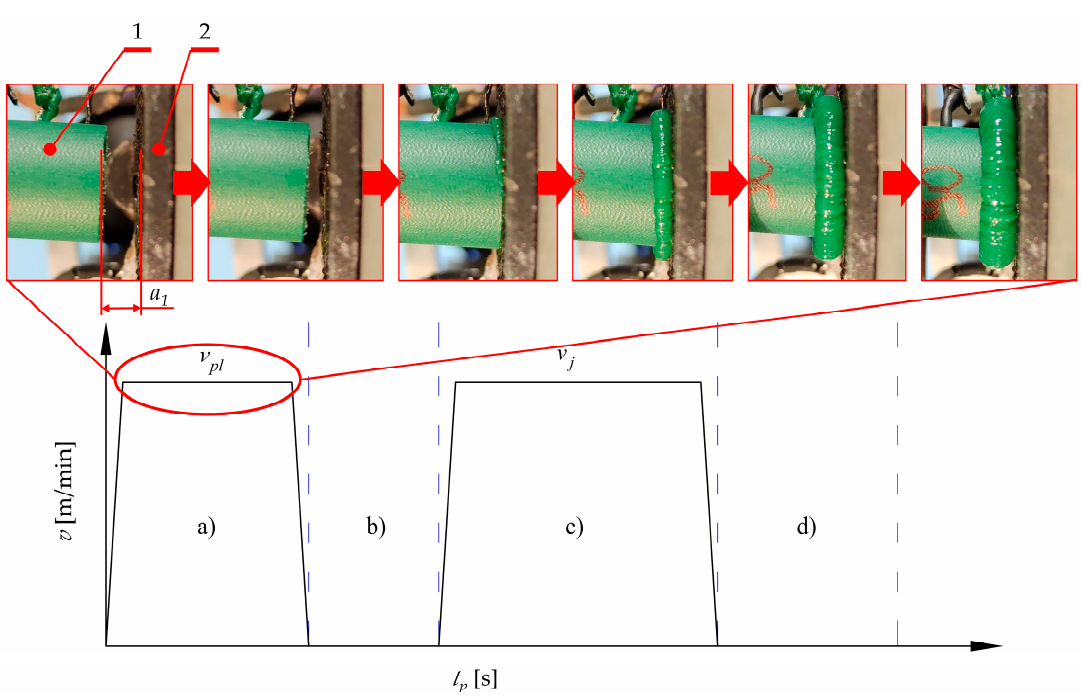
Figure 27. The cyclogram of the hot plate welding process with illustration of real plasticization process: (a) plasticization, (b) hot plate removal, (c) pressing operation, (d) cooling; v —velocity, v pl —plasticization velocity, v j —joining velocity, t p —process time, a 1 —initial distance between the end of the belt and the hot plate; 1—belt, 2—hot plate.